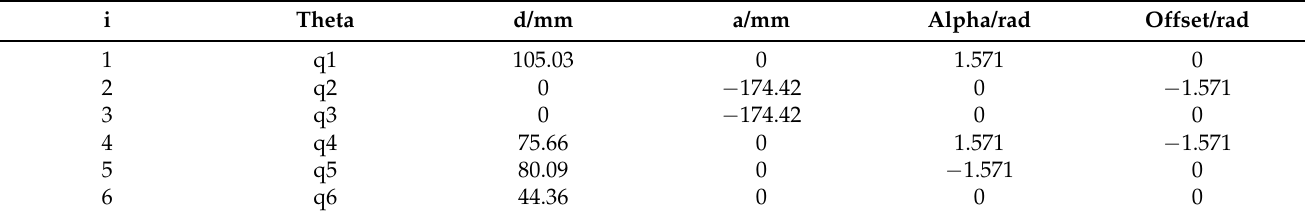
Table 1. D-H table of the simulated robot manipulator.